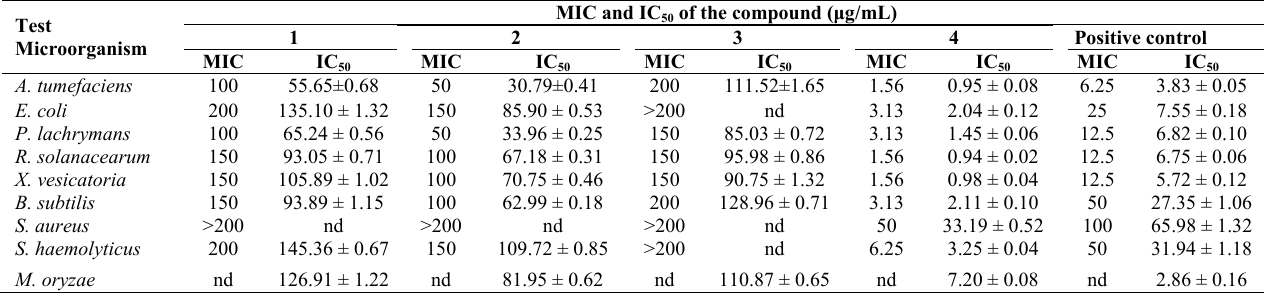
Note: MIC, minimum inhibitory concentration. IC , median inhibitory concentration. Positive controls for 50 bacteria and fungus M. oryzae were streptomycin sulfate and carbendazim, respectively. The 'nd' means not detected. Mean ± standard deviation of three independent experiments (three replicates for each